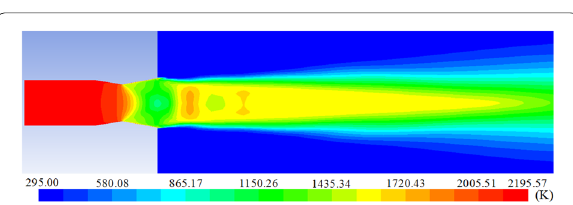
Figure 9 Static temperature contour of gas jet from a single engine